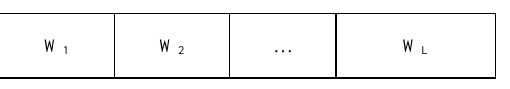
Figure 5. The chromosome of the best gene.